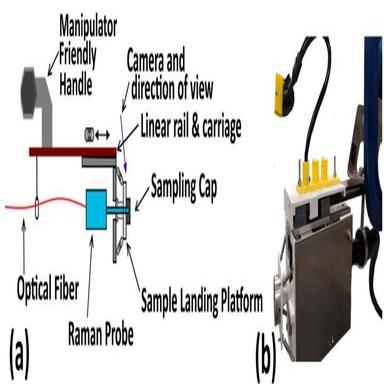
Contact Raman probe robotic mount for easier sample alignment, a) simplified schematic side perspective, (b) photo.